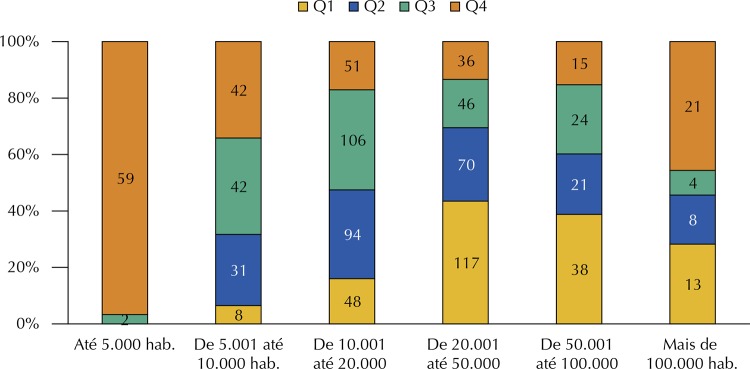
Número de municípios por porte populacional médio em 2013–2015, segundo quartis da média de despesa total com saúde per capita para o período, em gráfico de colunas 100% empilhadas.Nota: cada quartil representa um conjunto de 224 municípios (25,0% da amostra), em ordem crescente, com o primeiro quartil (Q1) incluindo os municípios com menores despesas per capita e o quarto quartil (Q4), os municípios com maiores despesas per capita.